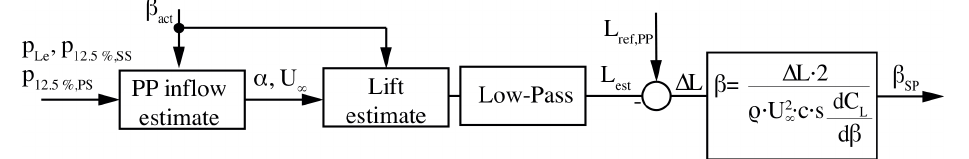
Figure 12. Feedforward controller based on surface pressure port measurements. The first two blocks corresponds to the lift estimation presented in Sect. 3.2. The flap angle set point is calculated based on the error in reference to a 10s mean. The latter is also based on surface pressure port